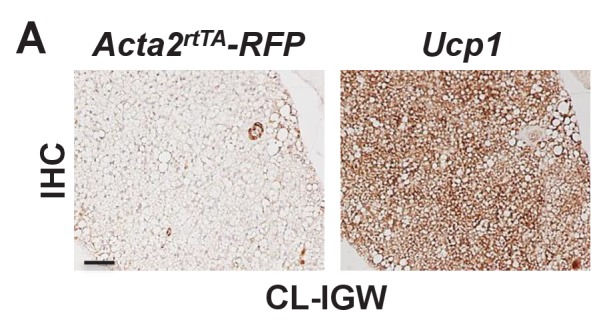
Acta2 genetic tools do not mark or track Adrb3 induced beiging.(A) I Representative RFP and Ucp1 IHC staining of IGW depot sections from Acta2rtTA; TRE-Cre; RosaR26RFP treated with CL for seven days (n= 6/group). Scale bar = 100 µm.